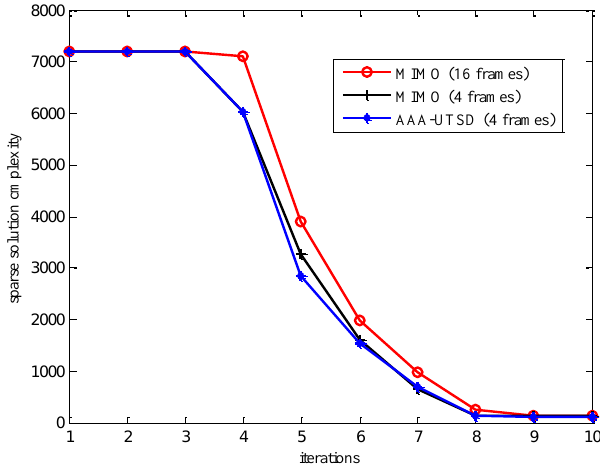
Figure 12. Computational complexity comparison of sparse solution calculation.